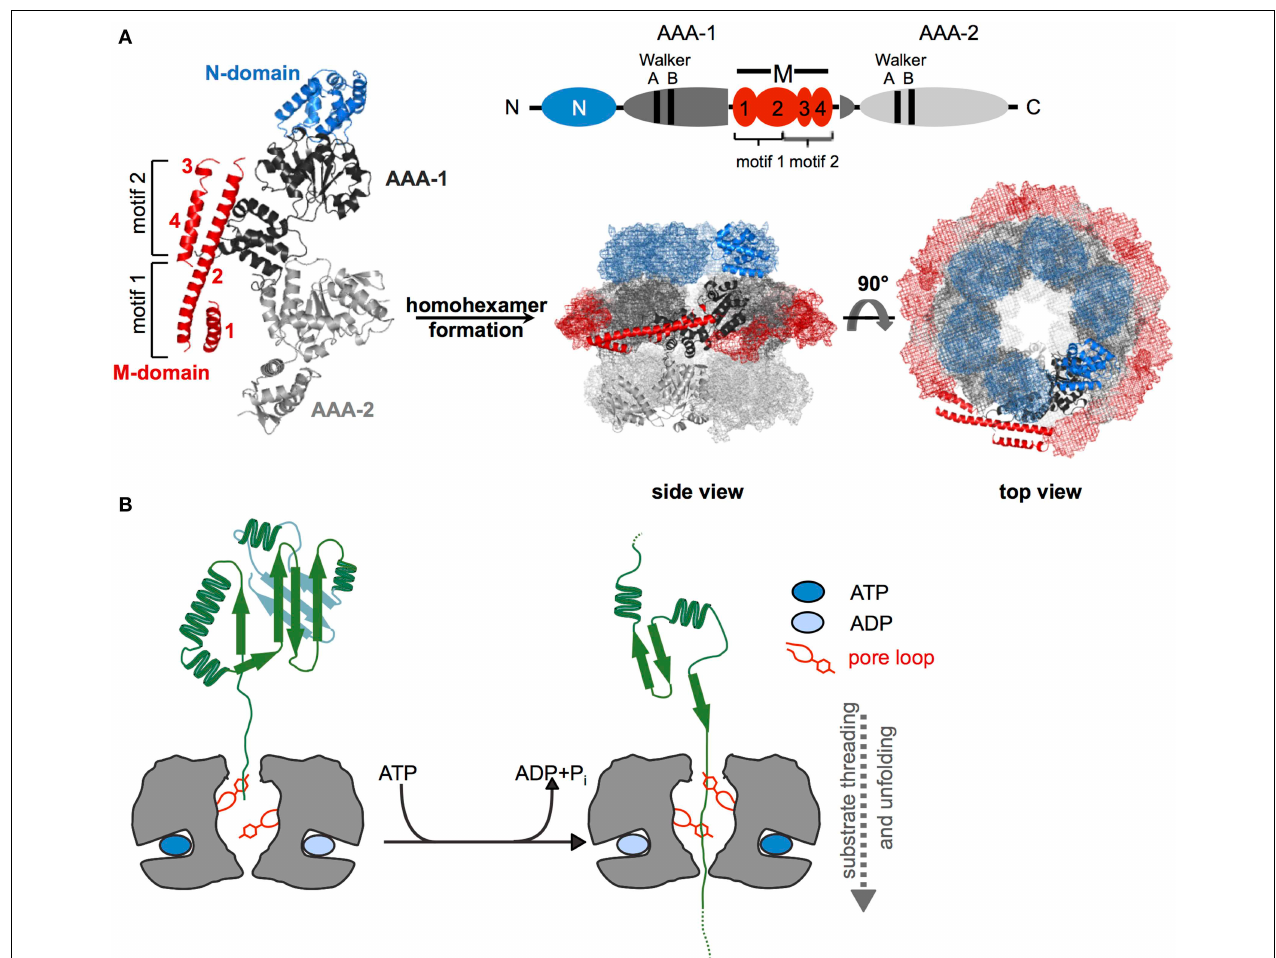
assembles into a hexamer consisting of three layers (rings) formed by N-domains, AAA-1/M-domains, and AAA-2 domains. A model of E. coli ClpB hexamers based on negative staining EM is given (Carroni et al., 2014). (B) Depiction of Hsp100 threading activity. Conserved aromatic residues (Tyr) are located on mobile loops at the central pore of the hexamer and contact substrate proteins. ATP binding and hydrolysis lead to conformational changes of loop segments, generating a pulling force that is linked to substrate unfolding and